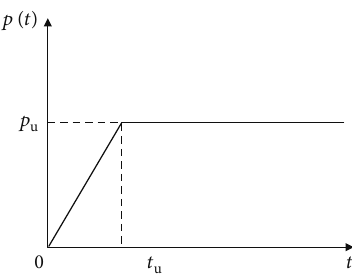
Figure 3: Relationship between load and time.